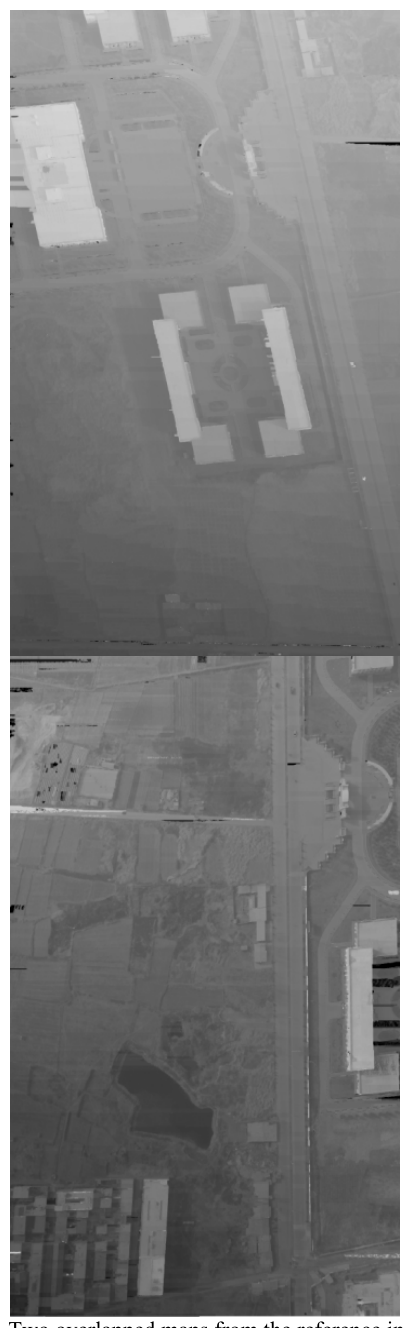
Figure 3. Two overlapped maps from the reference images and their